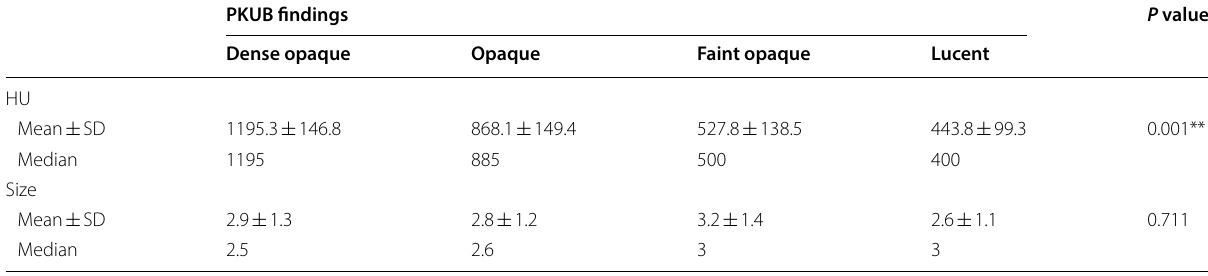
**Statistically significant difference ( P level < 0.01)